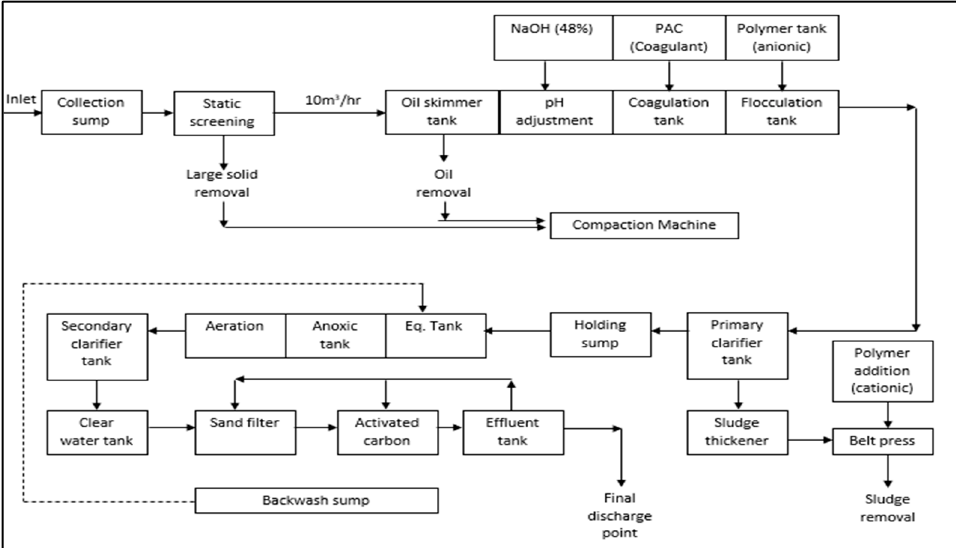
Figure 2. System flow in TBSWTS. Data from National Solid Waste Management Department (2012).